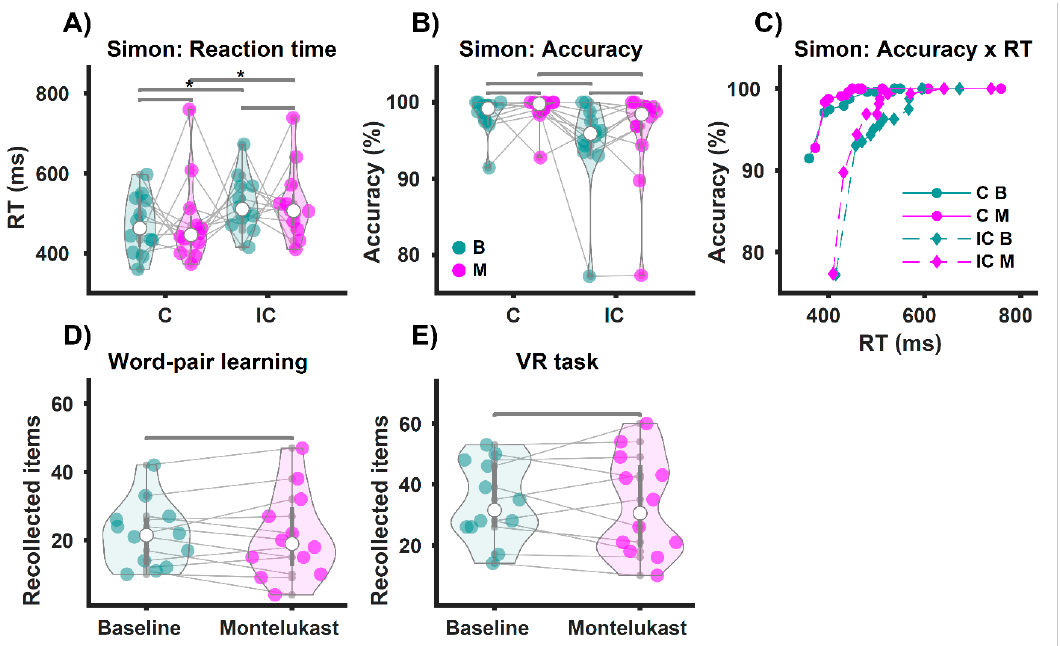
Figure 2. Behavioral results of the cognitive tests during the EEG. * p < 0.05. ( A ) Shows the reaction times for congruent ( C ) and incongruent (IC) trials of the Simon task. Participants were slower on the IC trials than on the C trials (Simon effect), both at baseline (B, green) and on the montelukast trials (M, purple). However, we observed no difference in response times when comparing baseline vs. montelukast for C and IC trials. In ( B ), accuracy indicates correct responses per condition as a percentage. We found no differences in accuracy for each comparison. ( C ) Shows accuracy as a function of response time. In the bottom panel, ( D , E ) show the results for participants’ performance on the memory tasks. There was no difference in the number of recalled word pairs for the semantic memory task (word pair learning, ( D )), comparing baseline vs. montelukast. We also found no difference in the number of recalled items for the episodic memory task (navigation through a virtual town, ( E